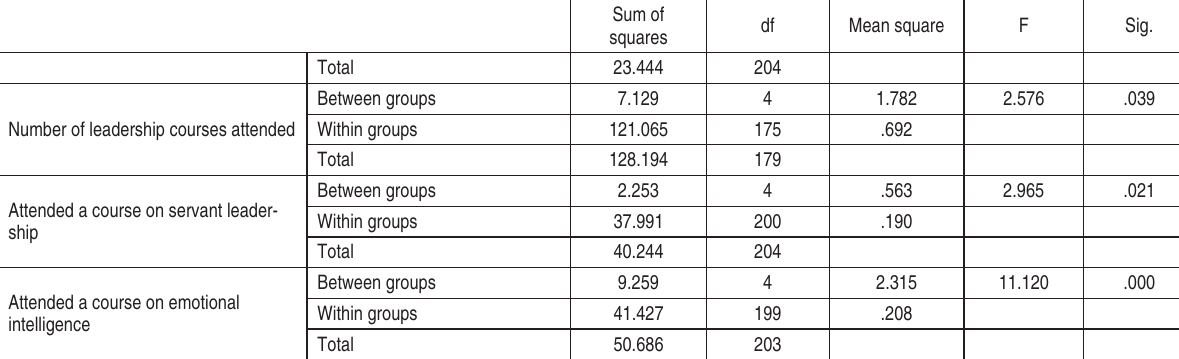
Table 4 (cont.). ANOVA analysis - perceived awareness of emotional intelligence